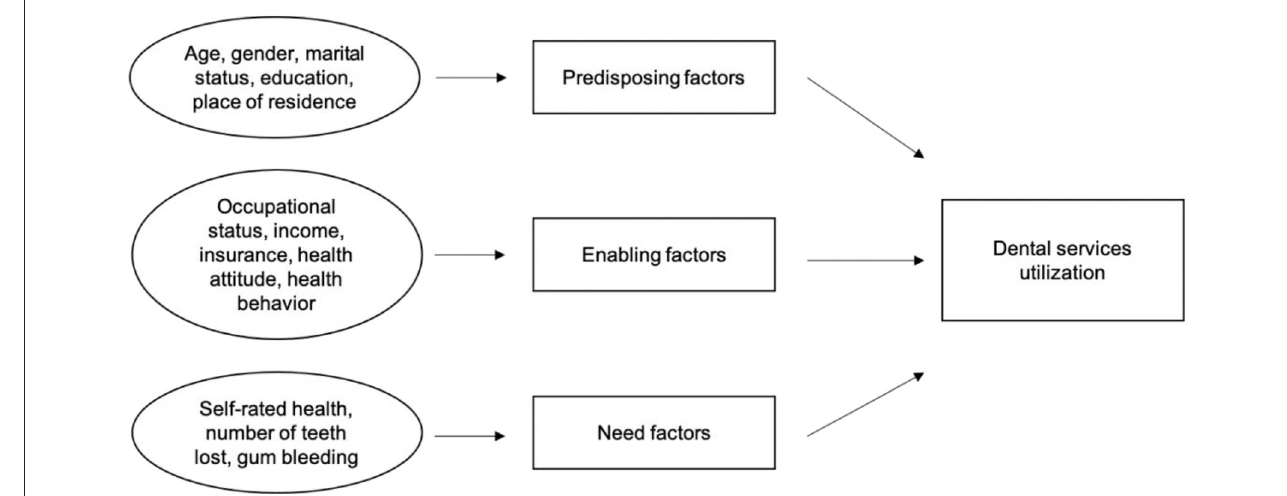
FIGURE 1 | Modified andersen dental services utilization